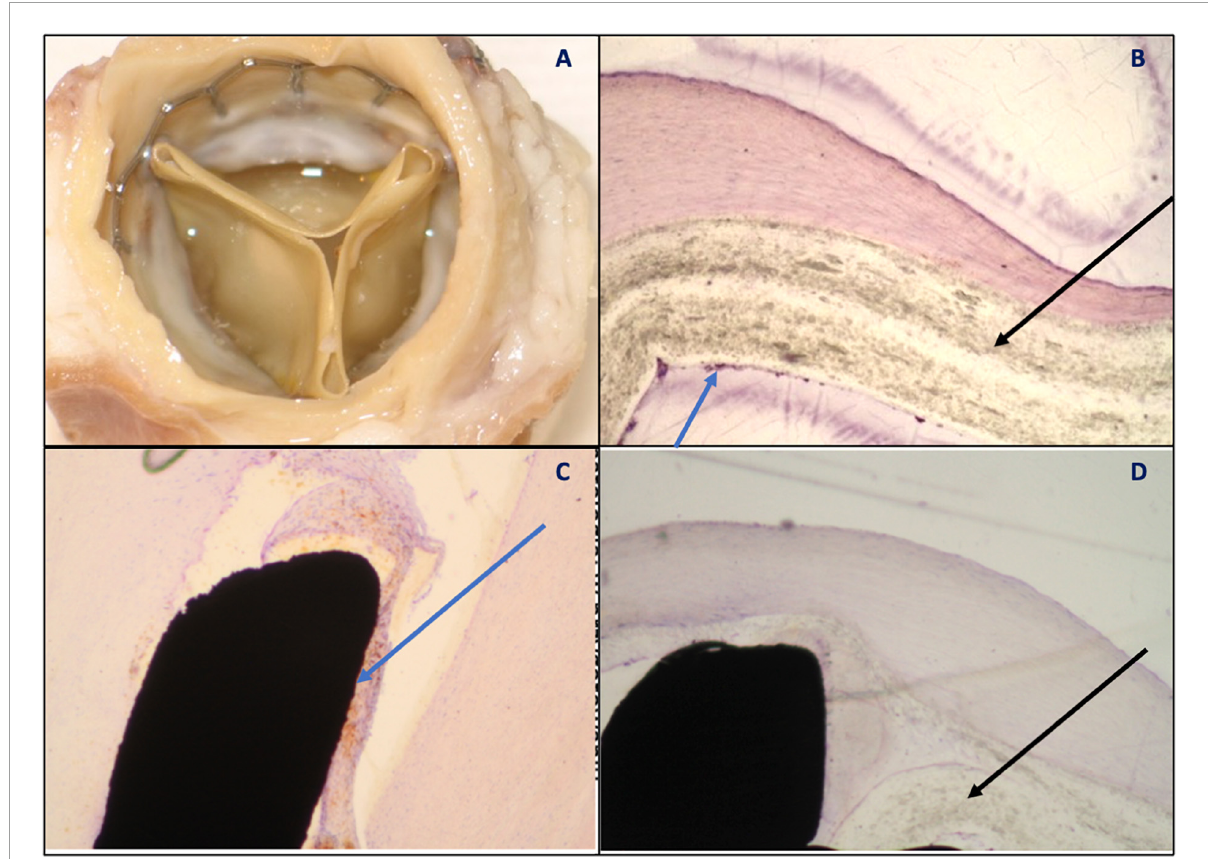
FIGURE7 (A) Vascular surface—thin cusps, unchanged, metal frame covered with relatively thick neointimal tissue indicating pannus formation. No thrombus visible; (B) polymer (black arrow) partially covered with neointima (blue arrow) encompassing single cells; (C) stent-tissue contact zone (blue arrow) with no signs of inflammation; and (D) polymer (black arrow) with no signs of resorption or penetration of cellular elements into the